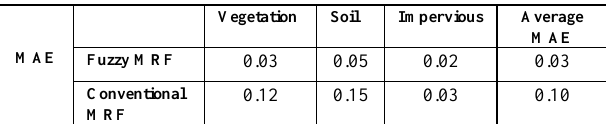
Table 4. Comparison of the mean absolute error (MAE) for the fuzzy integrated MRF model and the conventional MRF